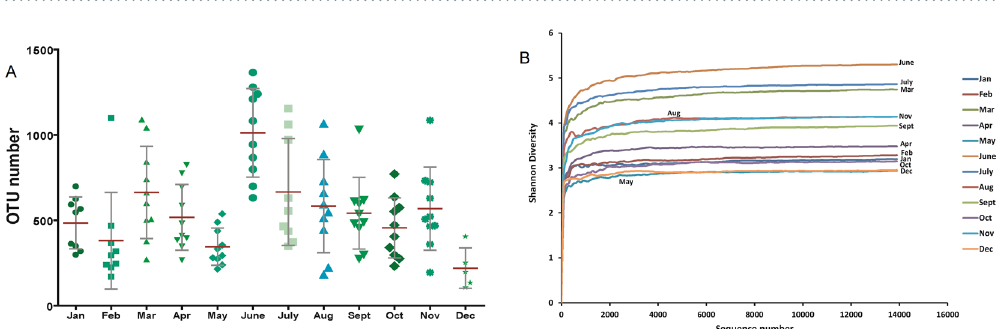
Table 1. Bacterial richness and diversity estimates at genetic distances of 3%. “ * ”indicated p < 0.05, “ ** ”indicated p < 0.001.